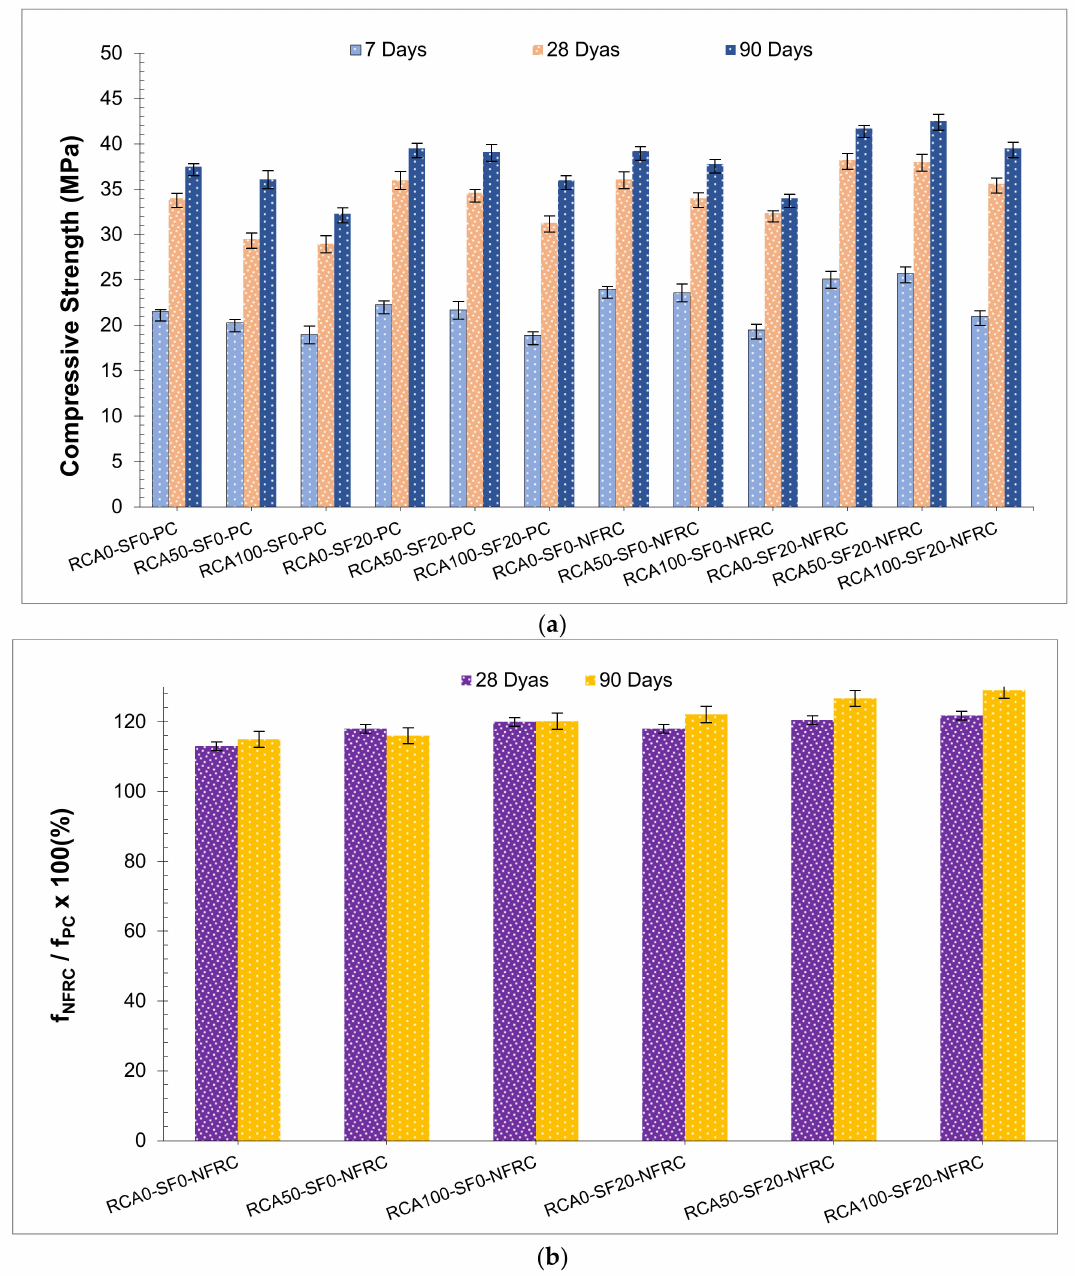
Figure 1. ( a ) Compressive Strength ( b ) Compressive Strength of Each NFRC Mix w.r.t Plain Con- crete